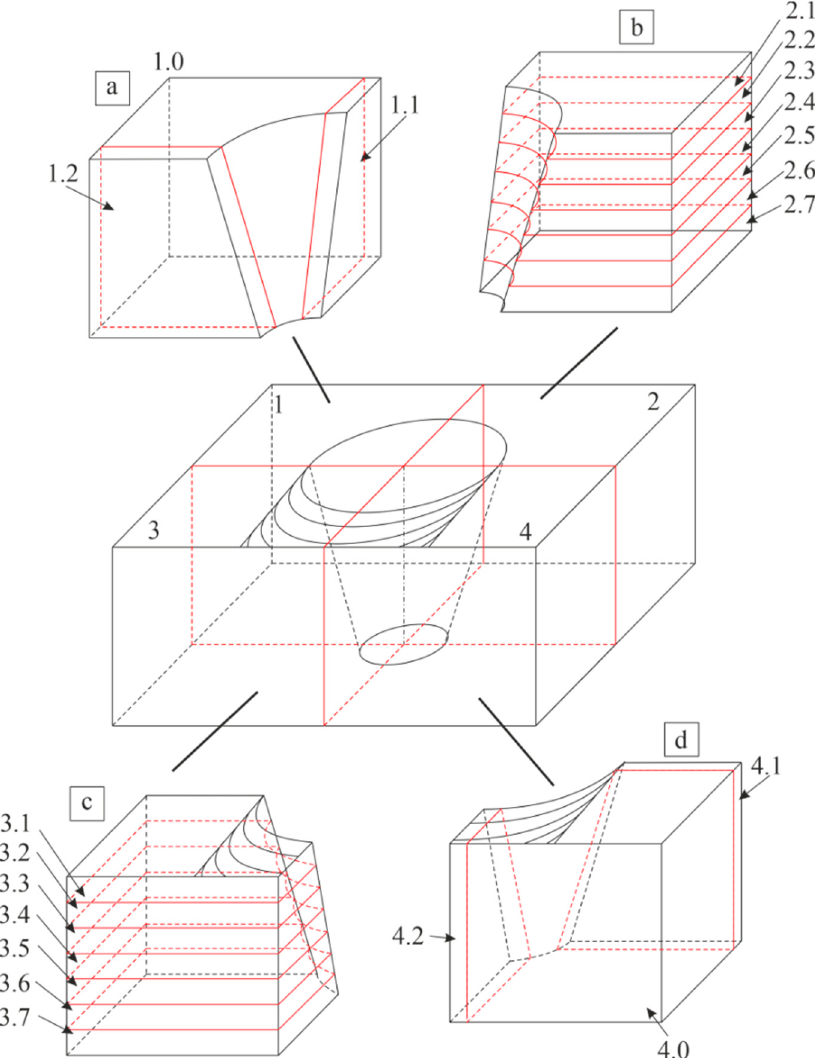
Figure 2. A diagram showing the sample cut-off scheme: ( a ) the leading edge of the exit hole on the retreating side (LE-RS), ( b ) the leading edge of the exit hole on the advancing side (LE-AS), ( c ) the trailing edge of the exit hole on the retreating side (TE-RS), ( d ) the trailing edge of the exit hole on the advancing side (TE-AS).